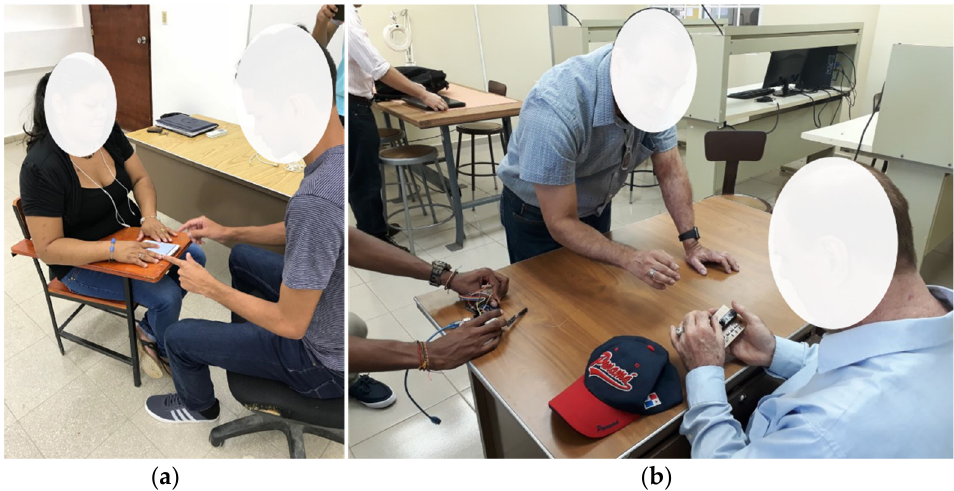
Figure 6. PwVD prototypes training. ( a ) Mobile training. ( b ) RF Device training.